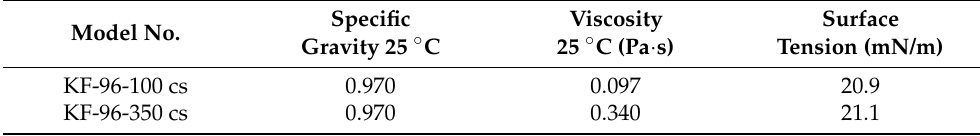
Table 2. 1 Properties of Silicone oil used as the working fluid. Model